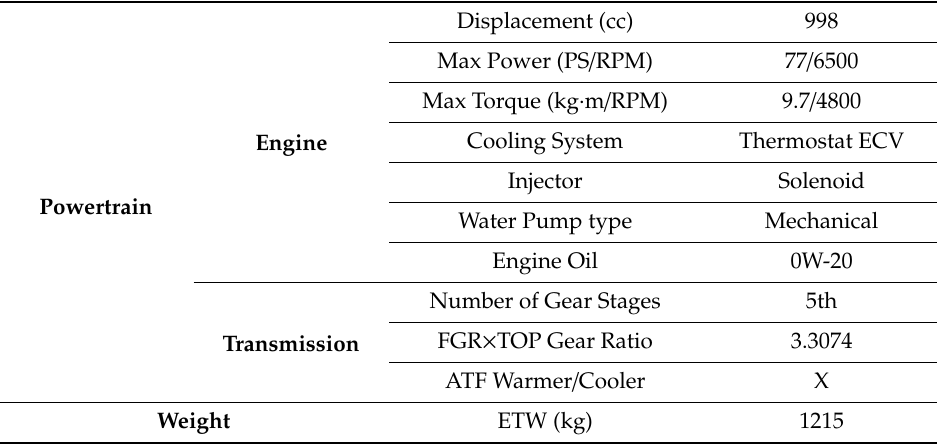
Table 1. Specifications of the vehicle used in the